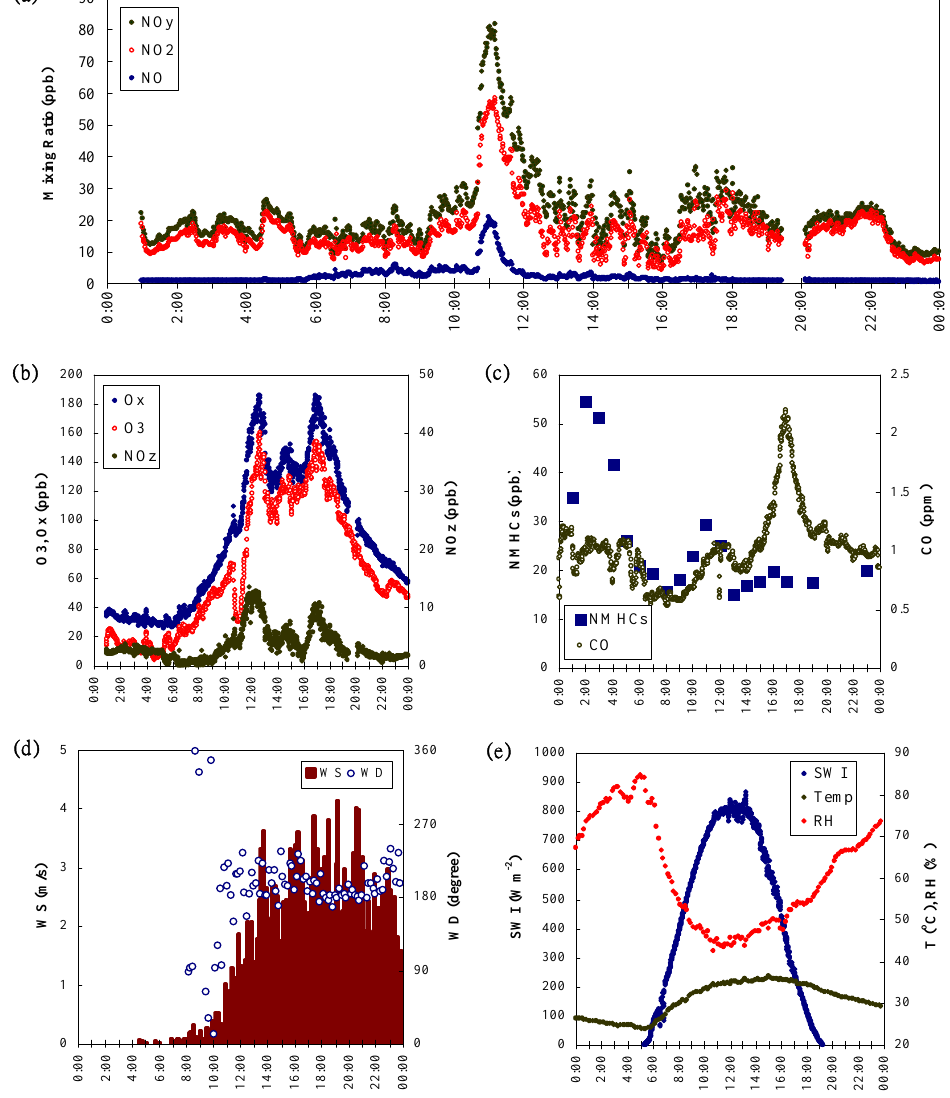
Fig. 3. Time series of the mixing ratios of trace gases and the meteorological conditions in Beijing for 3 August 2008. (a) NO, NO 2 , and NO y ; (b) O x , O 3 , and NO z ; (c) NMHCs and CO; (d) wind speed and direction; (e) ambient temperature, RH, and